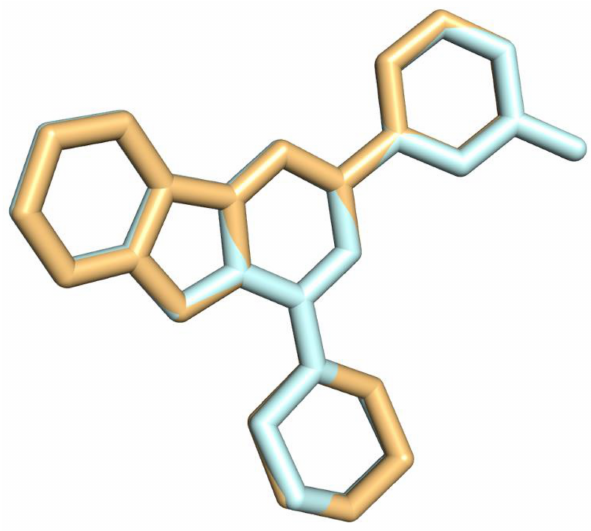
Figure 6. Superposition of the IFdocked X6K pose (blue color) and its native conformation (gold color) in 4L23. Picture made by PYMOL.